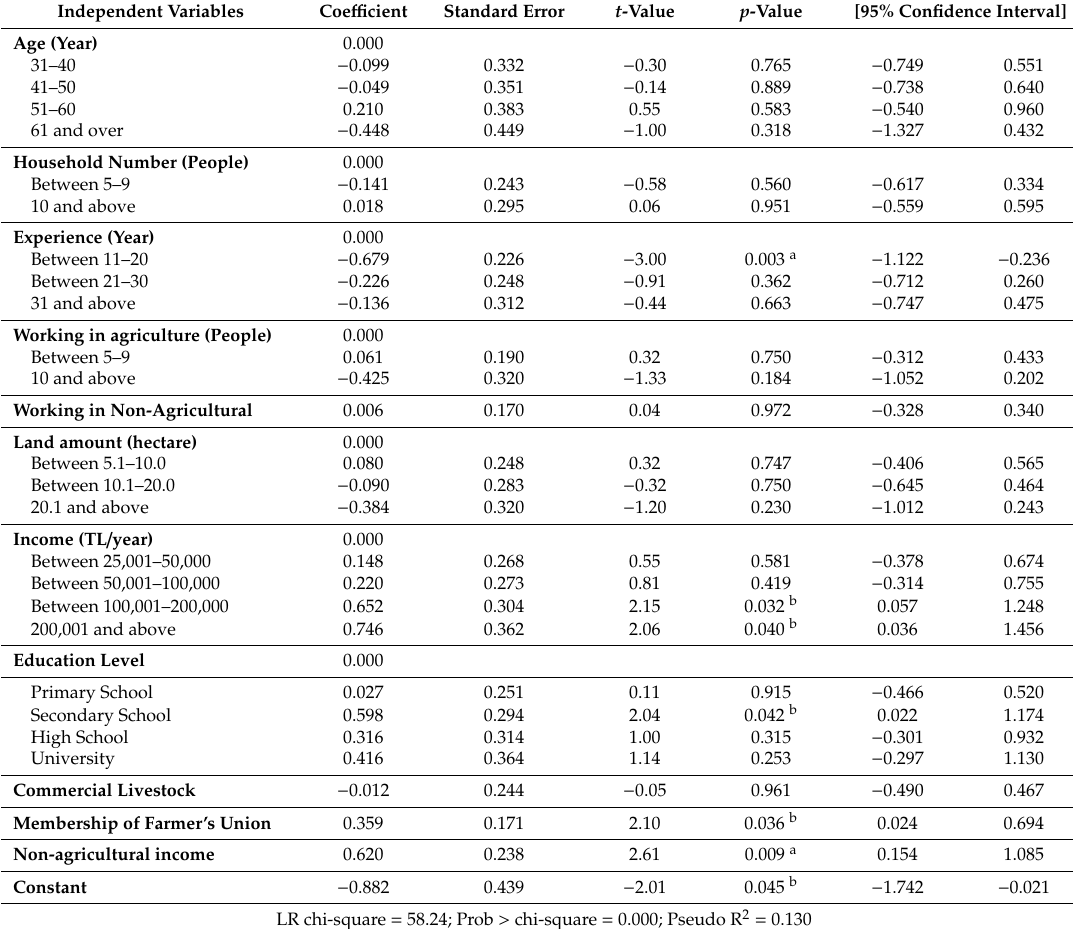
Table 2. The Heckman’s first-stage model, Probit model / selection model, estimation